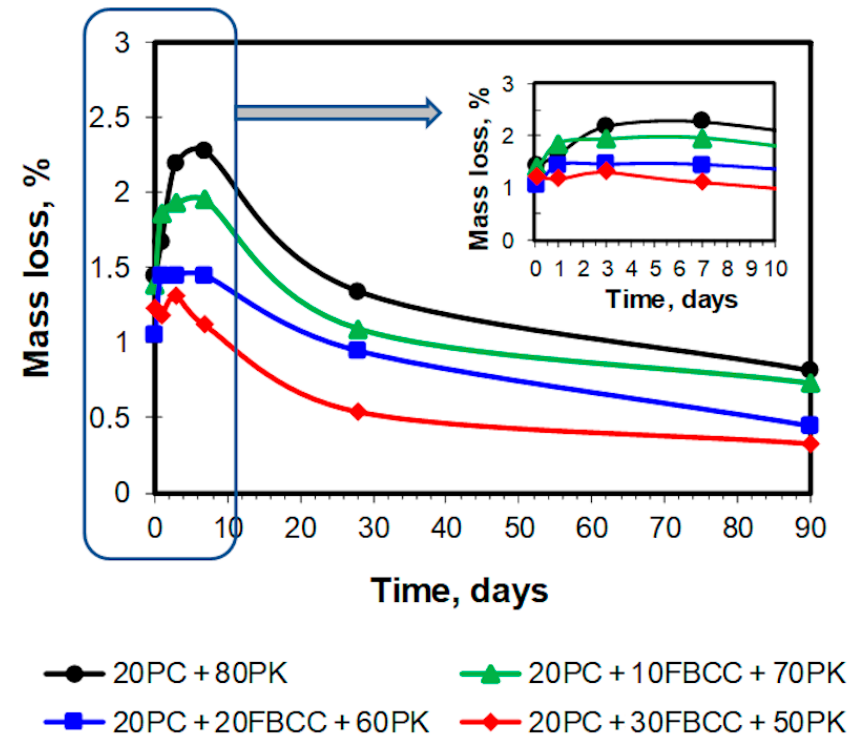
Figure 8. Mass loss corresponding to decomposition of Ca(OH) 2 .